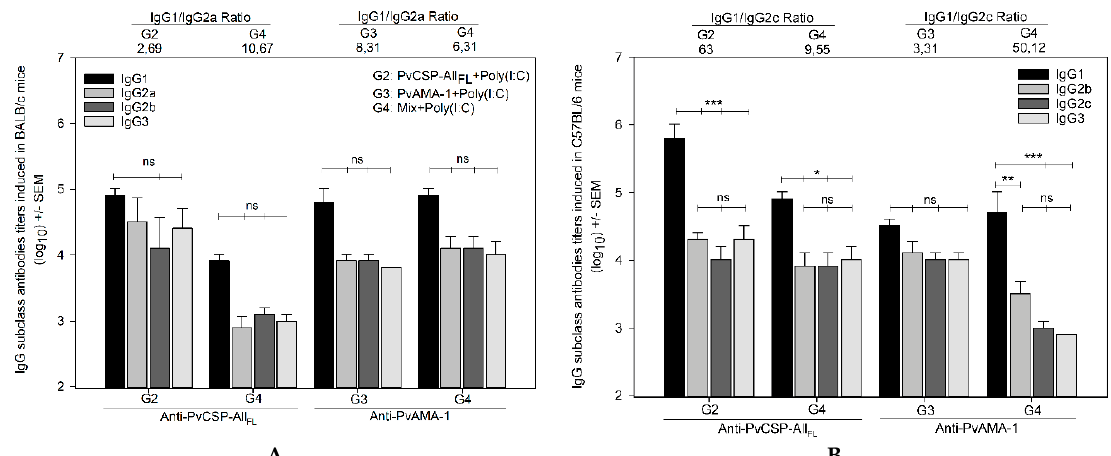
Figure 3. IgG antibodies subclass titer analysis. The IgG antibodies subclasses IgG1, IgG2a, IgG2b, IgG2c, and IgG3 induced in BALB/c ( A ) and C57BL/6 ( B ) mice were measured by ELISA against PvCSP-All FL and PvAMA-1. The results are expressed as the arithmetic mean titers of each group in log 10 ± SEM and were statistically compared using one-way ANOVA followed by Tukey‘s test for multiple comparisons. Significant differences between groups are denoted on the graph: * p < 0.05, ** p < 0.01, and *** p < 0.001. Nonsignificant (ns) differences are indicated ( p > 0.05). The titers were used to calculate the IgG1/IgG2a ( A ) and IgG1/IgG2c ( B ) ratio, and the ratios are indicated above the plot according to the groups.